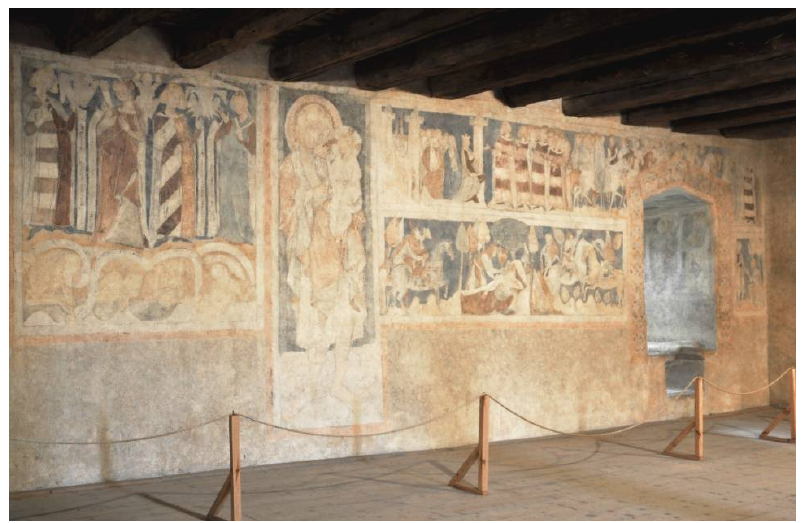
Figure 24. Siedlęcin, ducal tower, Great Hall. Paintings on the southern wall. First half of the 14th century. Photo by Przemysław Nocuń, the author’s own work.